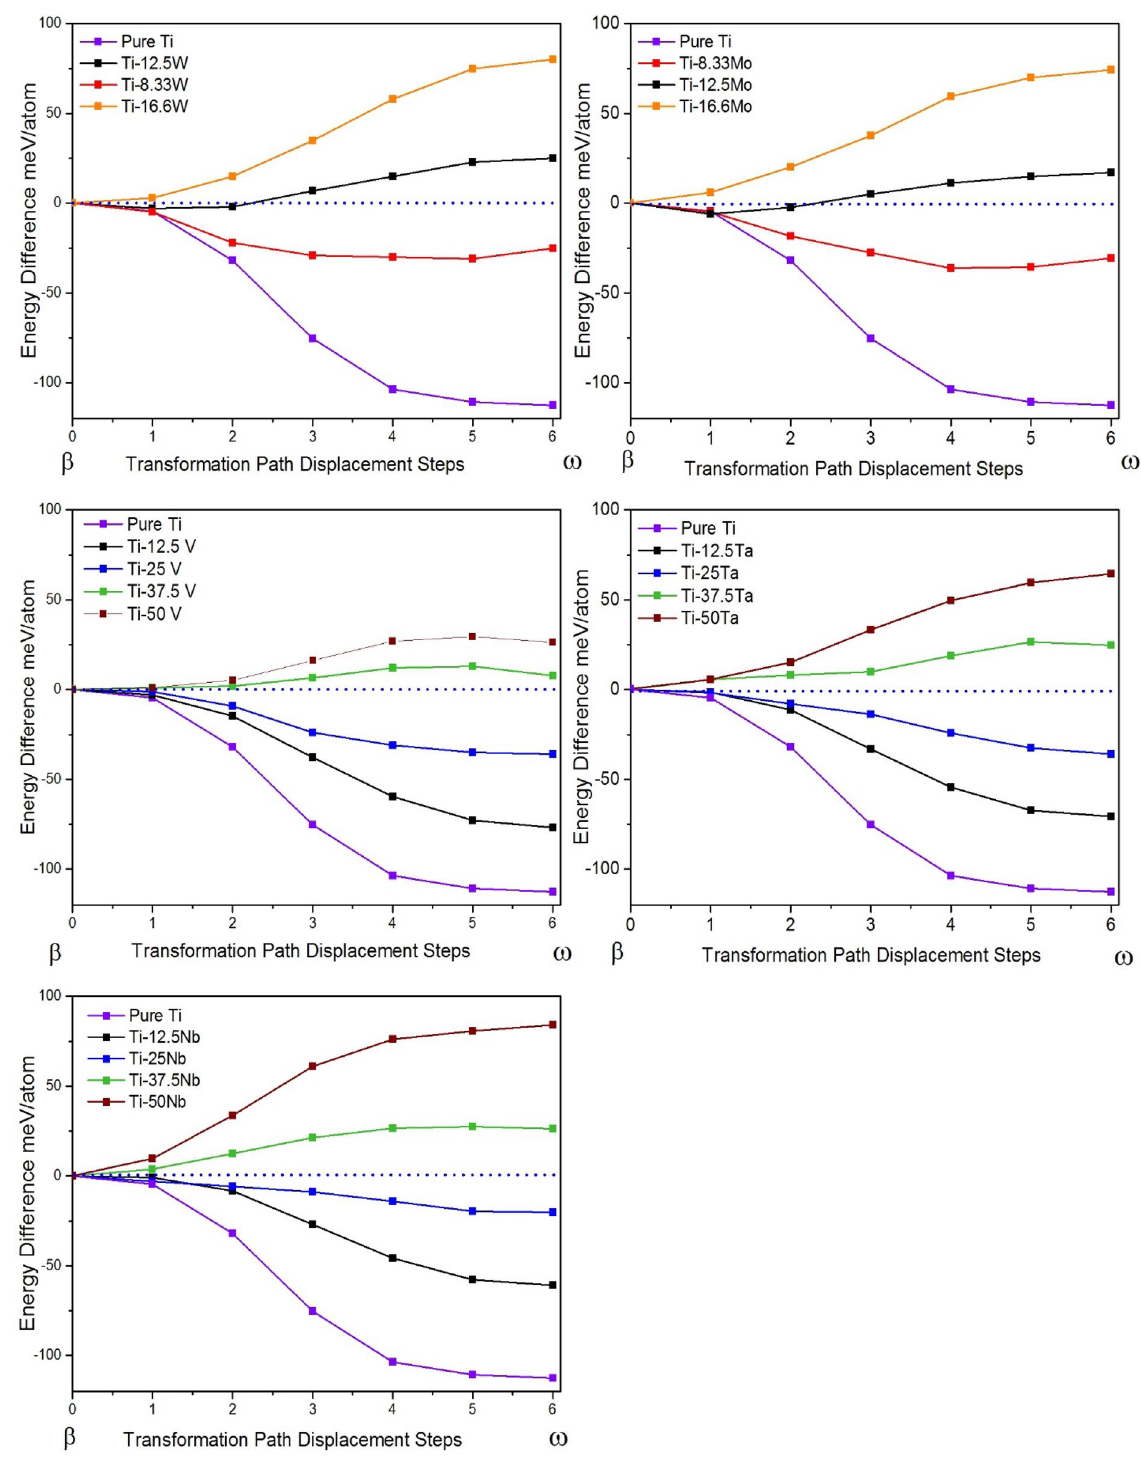
Figure 4. MEPs of β → ω transformation for Ti-X (X = W, Mo, V, Ta, and Nb)